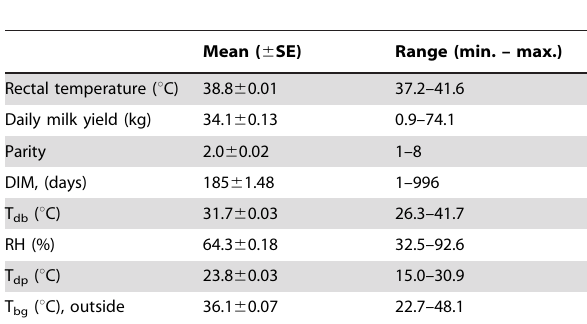
Table 1. Average ( 6 SE) and range of animal and environmental variables used in the analysis.